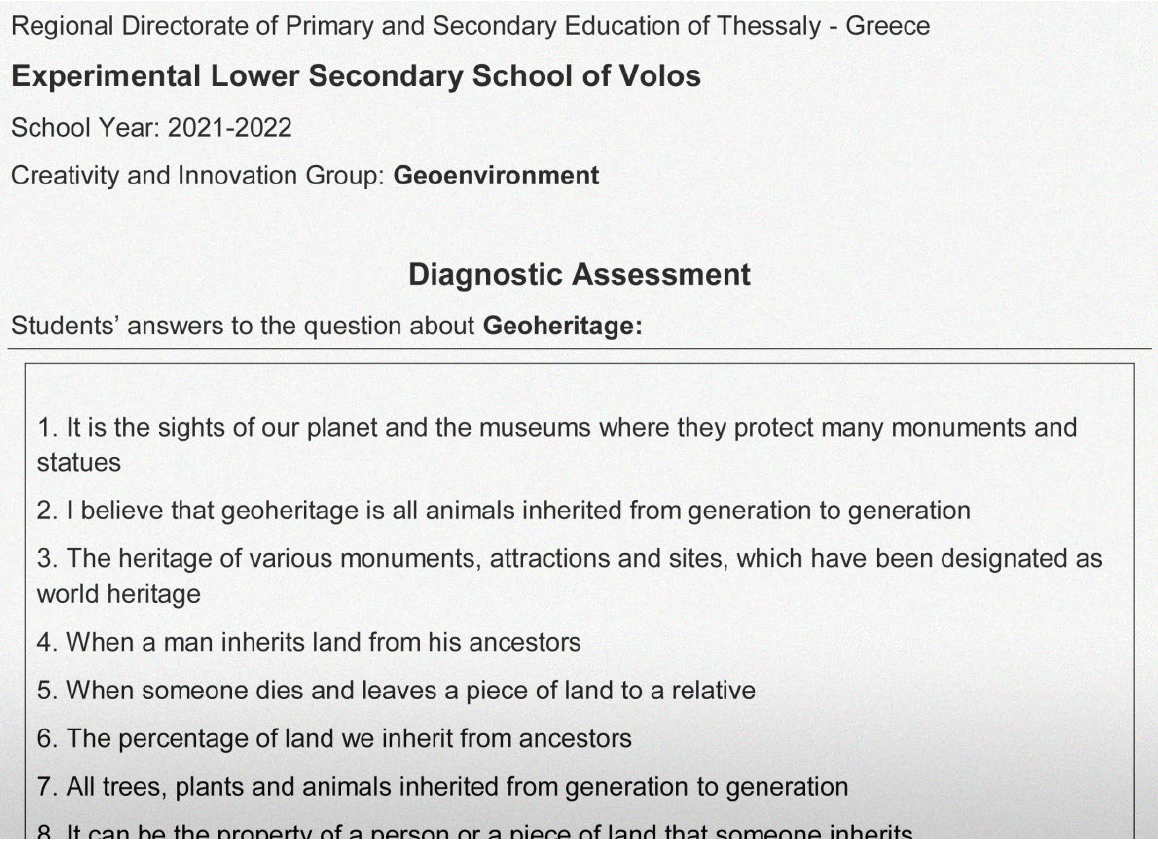
Figure 2. Part of the document with students’ answers (on the concept of geoheritage).